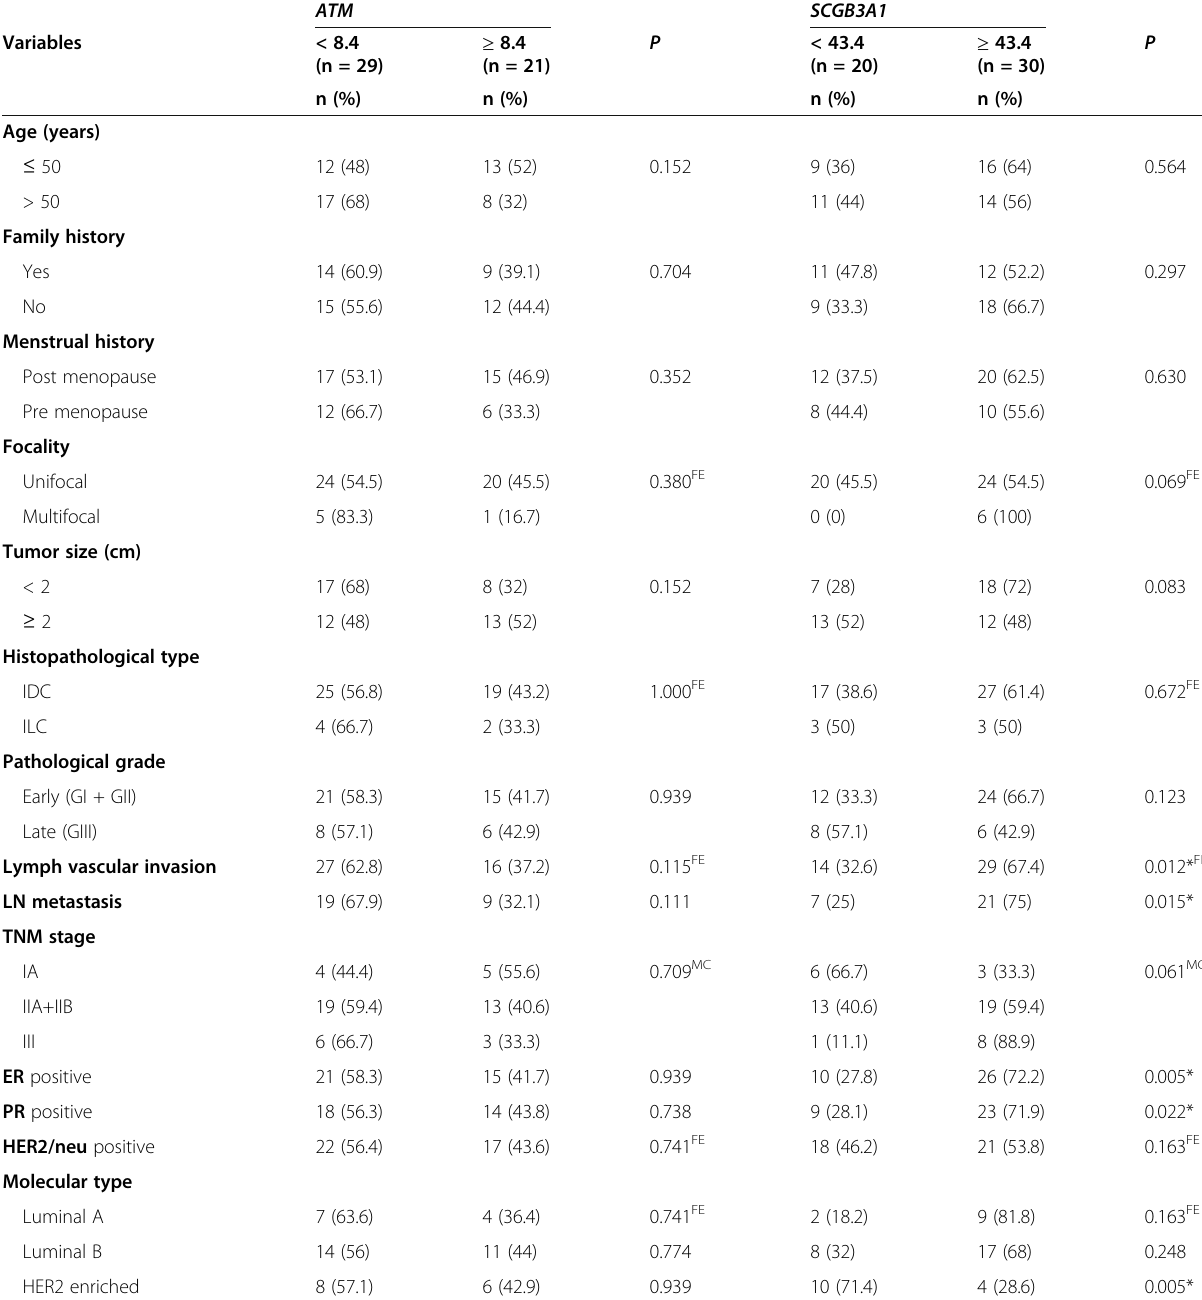
Table 4 The associations between ATM and SCGB3A1 methylation frequency and the clinicopathological characteristics of the studied patients ATM SCGB3A1